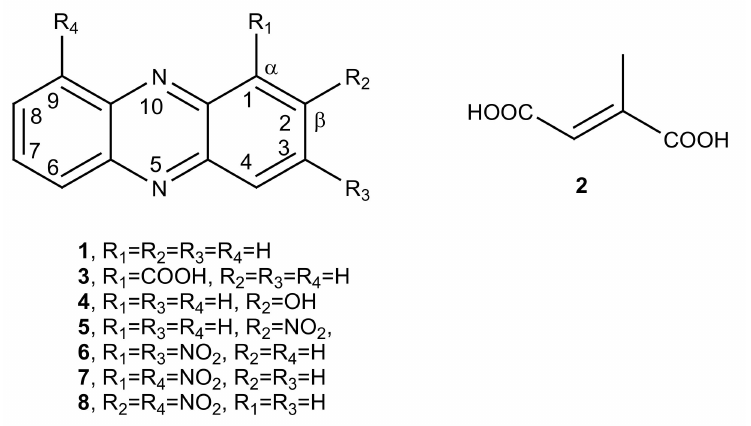
Figure 2. Structure of phenazine ( 1 ), its natural analogs 1-carboxy and 2-hydroxy-phenazine ( 3 and 4 ), and four mono- and dinitro derivatives ( 5 – 8 ) and mesaconic acid ( 2 ).